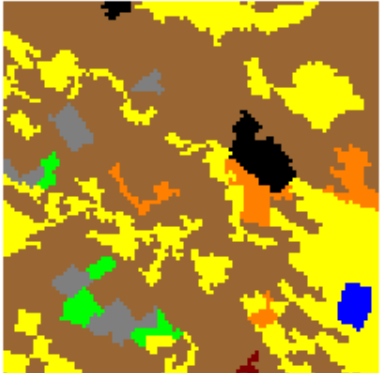
Figure 5. Visualization of a picked world on the Great Hungarian Plane. The black urban area is Jászkarajenő village, between Szolnok and Kecskemét county seats.